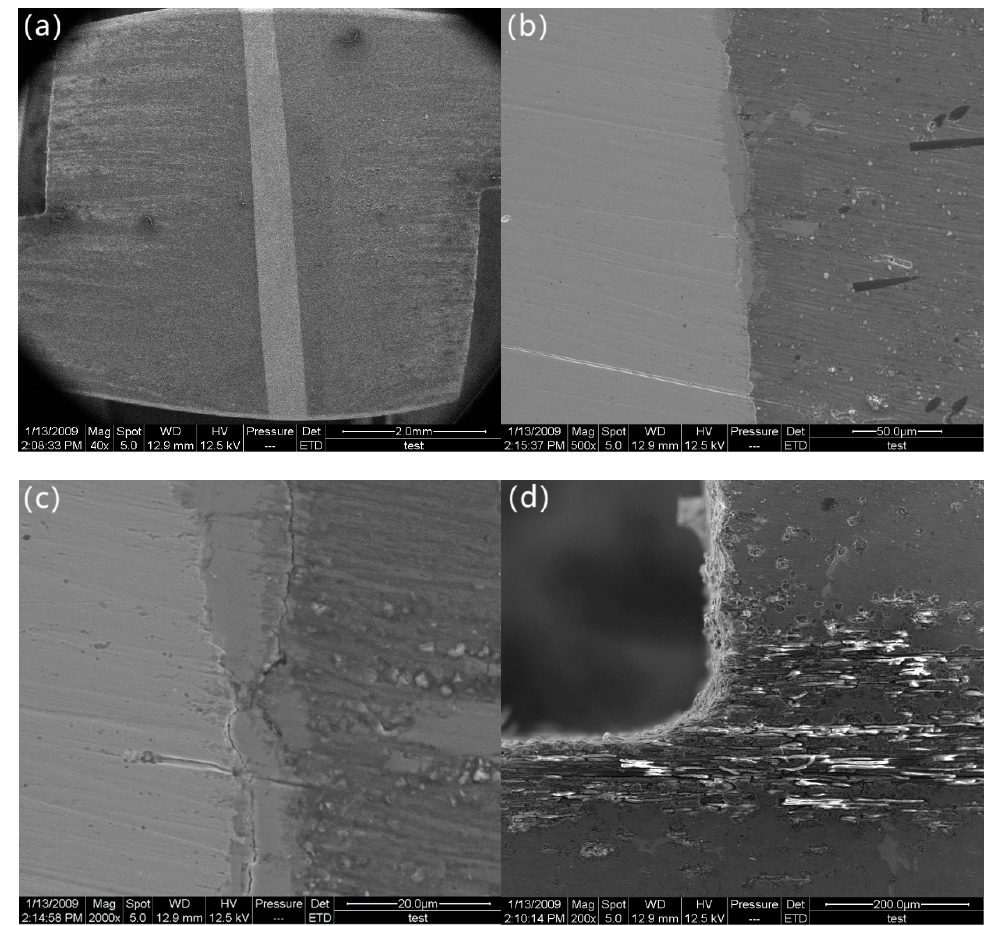
Figure 4. Morphology of specimen in later elastic deformation stage: ( a ) the z-pin, ( b ) micro-cracks in z-pin/matrix interface in low magnification, ( c ) micro-cracks in z-pin/matrix interface in high magnification, and ( d ) the notch.